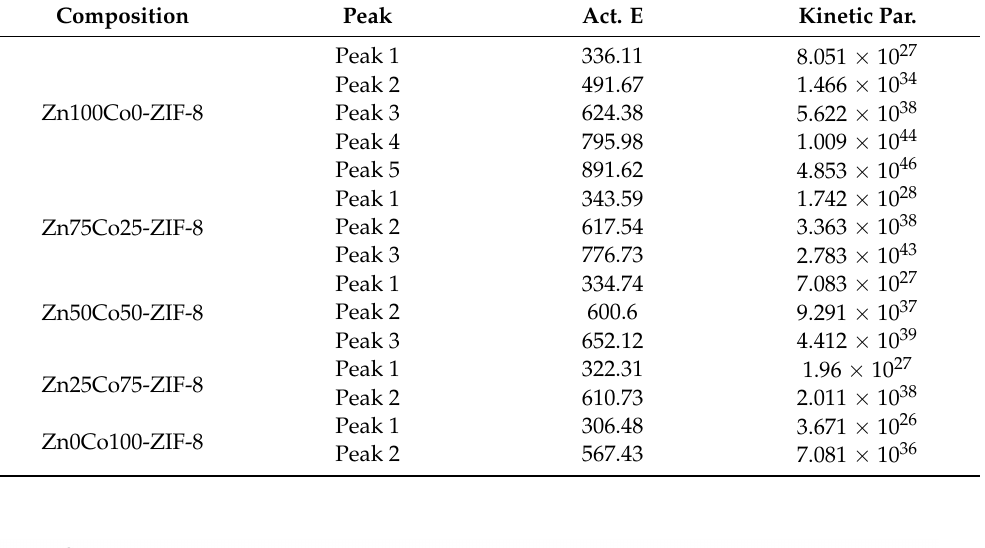
Table 2. Activation energy and kinetic parameter of the Zn 1-x Co x -ZIF-8 pyrolysis process calculated by the non-isothermal method.